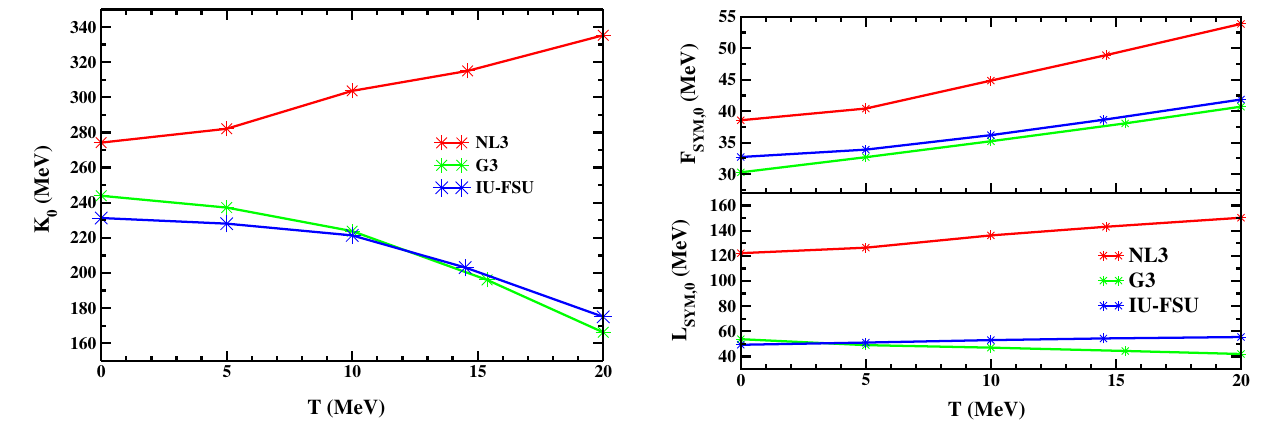
Fig. 3 Variation of incompressibility at saturation density with tem- perature for SNM ( t = 0)